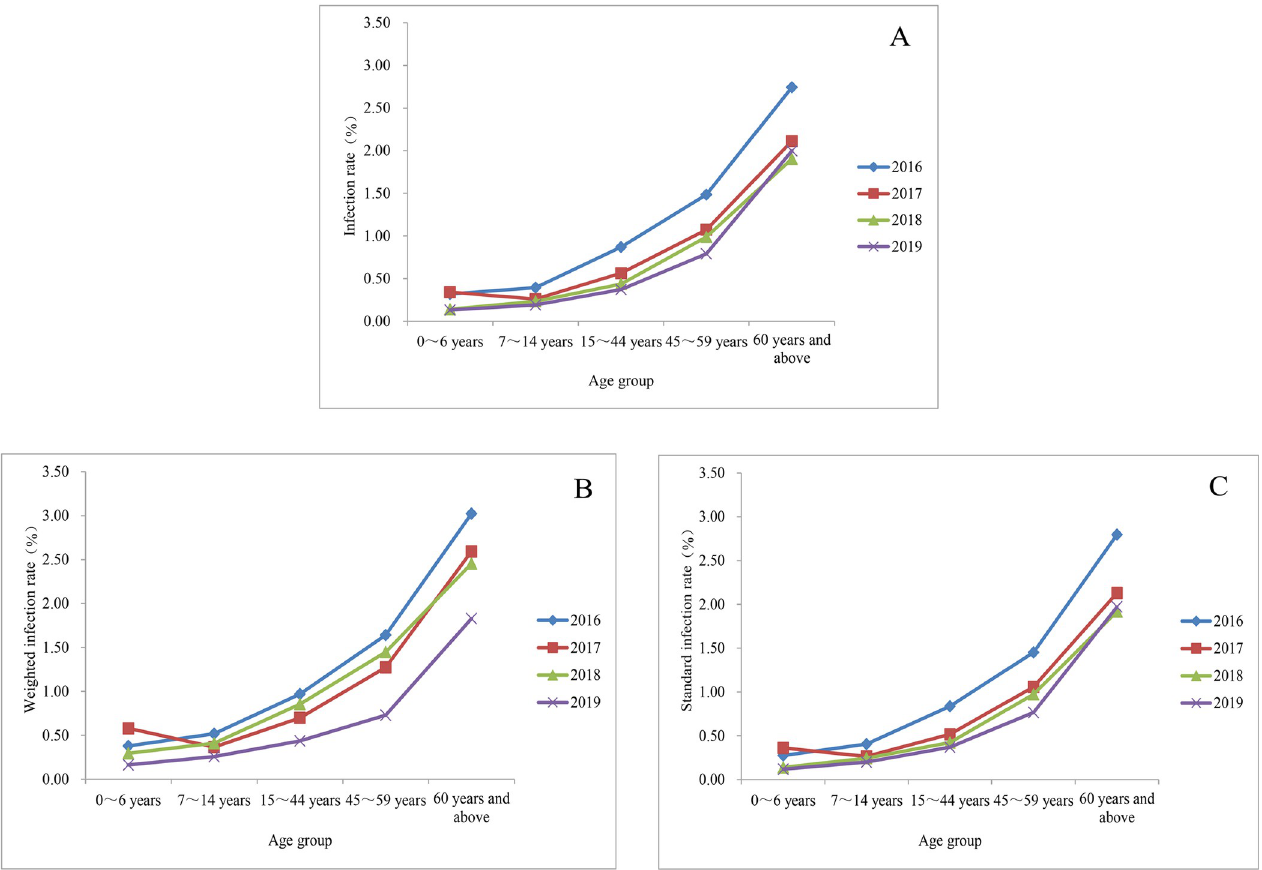
Fig 5. Age distribution of hookworm infections from 2016 to 2019 according to the national surveillance. A. Infection rate; B. Weighted infection rate; C. Standard infection rate.